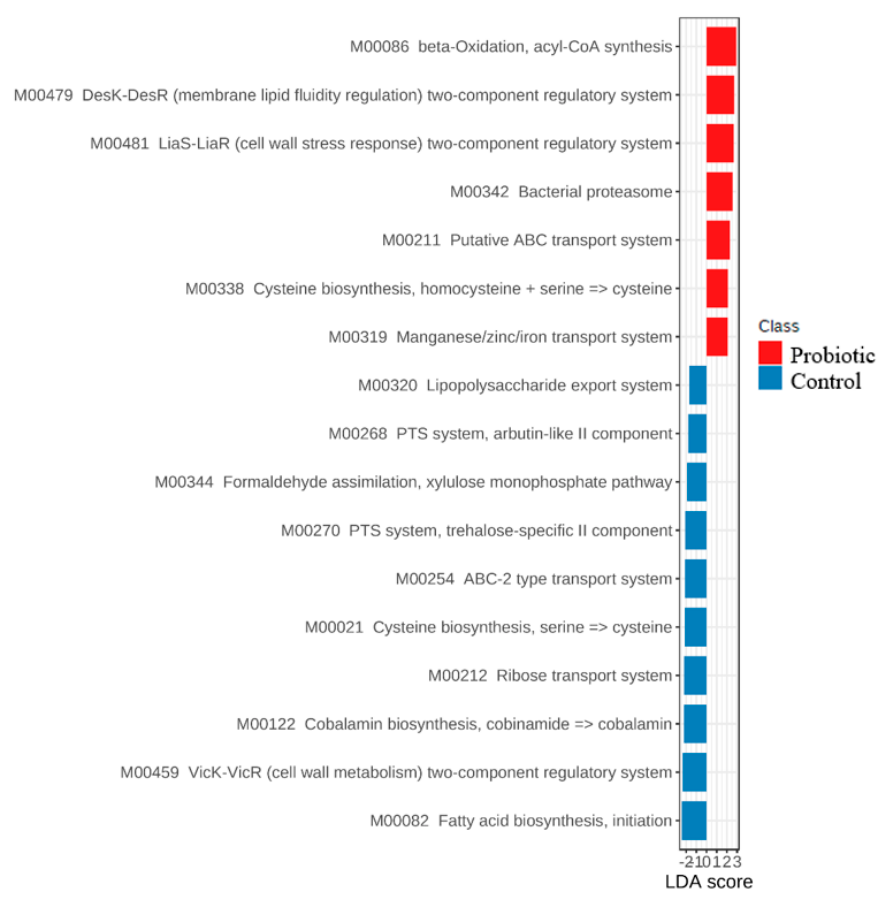
Figure 6. LDA score of modules that statistically differ ( p < 0.05) between the control and probiotic groups fed the lower protein and fiber diet—day 21 ( A ) and the higher protein and fiber diet—day 49 ( B ).